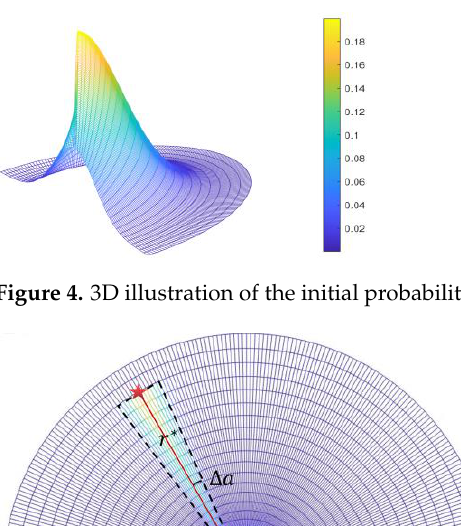
Figure 3. Illustration of the state lattices of the nonholonomic robot.